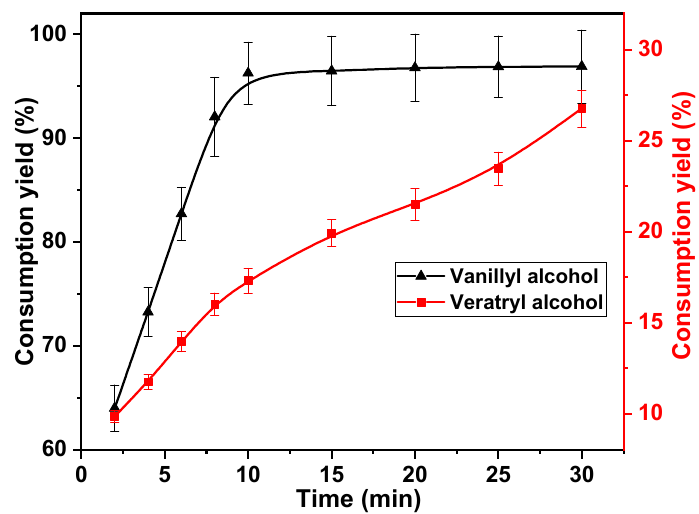
Figure 3. Effect of reaction time on vanillyl alcohol and veratryl alcohol consumption.